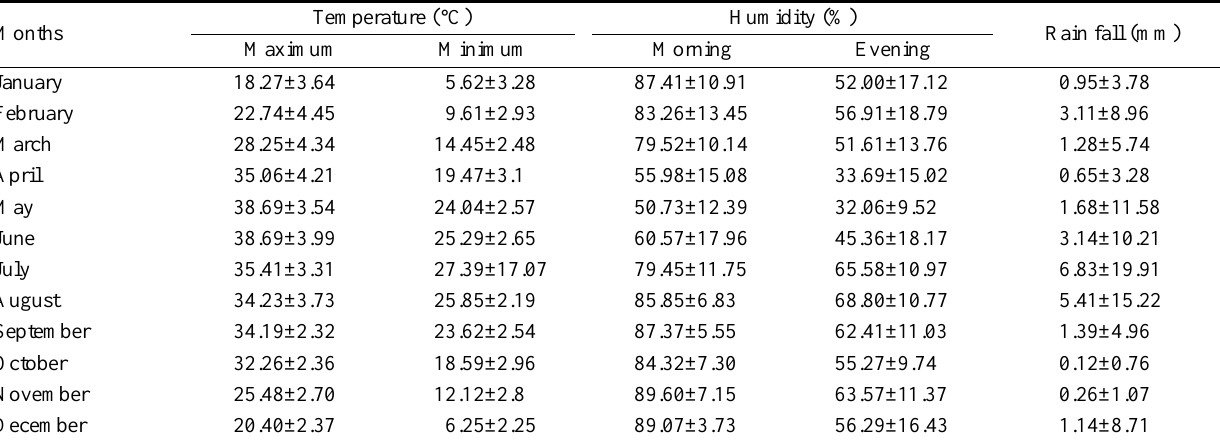
Table 1. Average means of temperature, humidity and rain fall during the period of survey at Mona equine breeding farm in